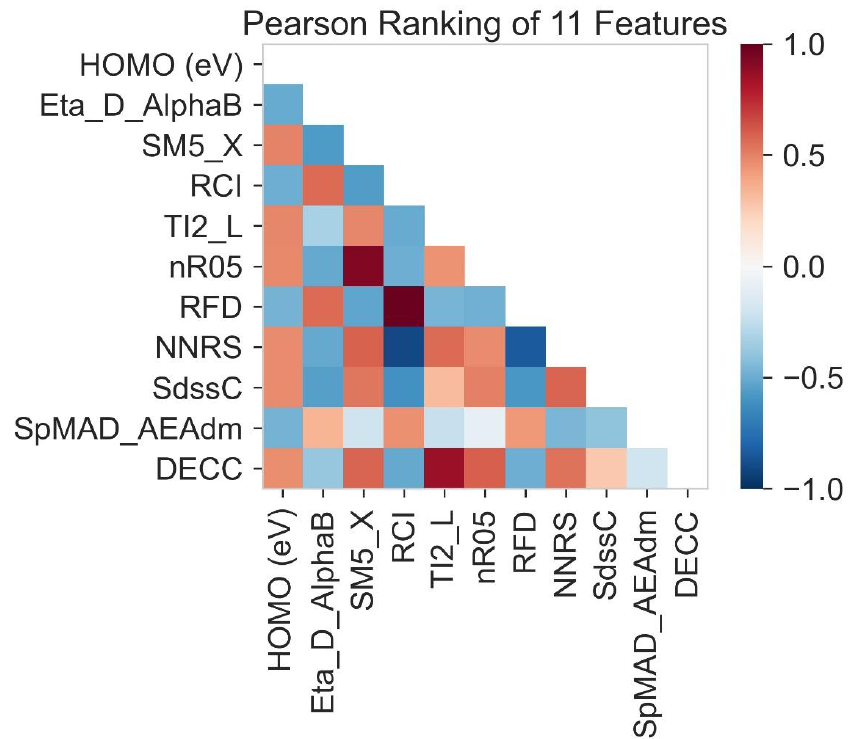
Figure 1. Correlation between HOMO and molecular descriptors. For model training, calculated molecular descriptors are used as a source of